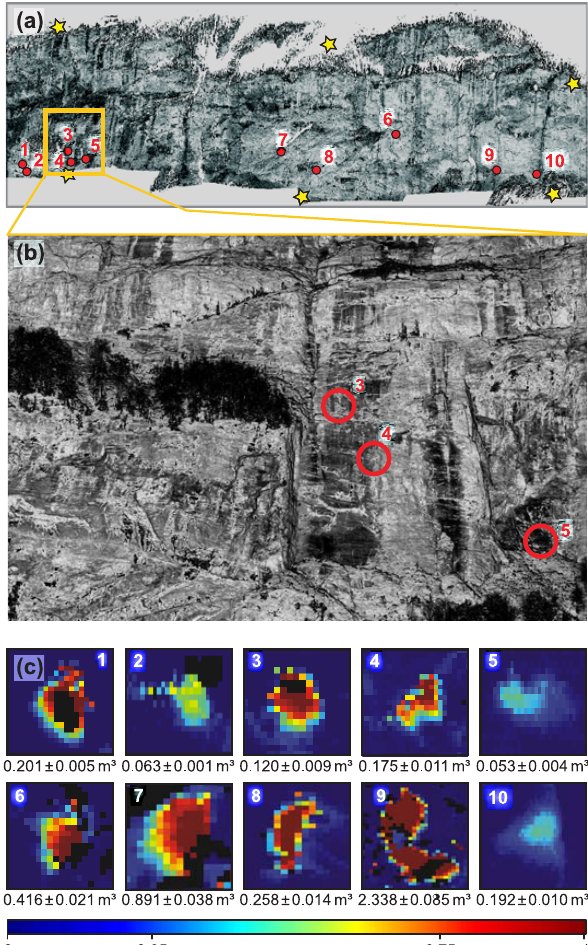
Figure 4. Rockfall detachment zones determined from TLS map- ping. (a) Overview (aligned point cloud data) of the about 2.7km long, instrumented east-facing stretch of the Lauterbrunnen Valley with rockfall detachment zones (red dots) and seismic stations (yel- low stars, station names and distances see Fig. 1). (b) Close-up of the southern rock wall section with the detachment zones of events 3–5 at elevations less than 100m above the talus slope. (c) Boxes show rockfall detachment patterns on the rock wall. Released rock volumes and uncertainties are given below each box. Event numbers are the same as in (a) and Tables 1 and